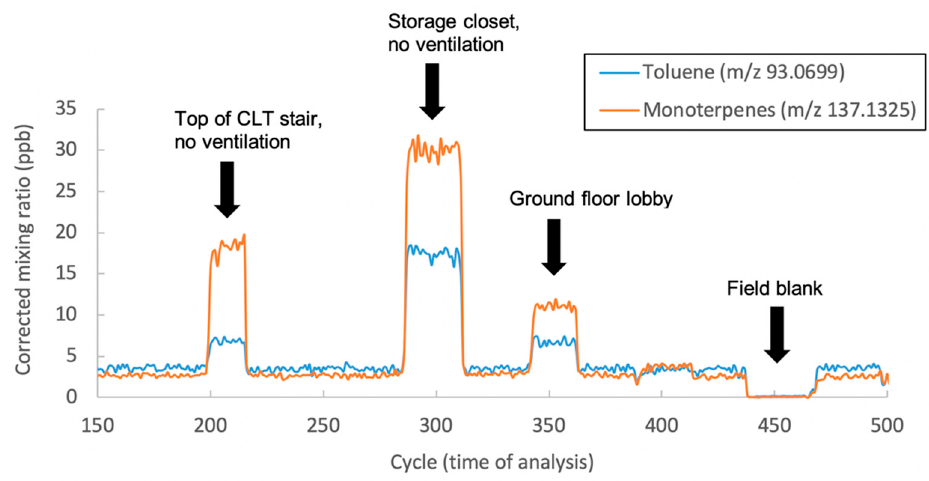
Figure 4. Results for toluene and monoterpenes over PTR-TOF-MS analysis time for one-minute grab samples from various building locations and one field blank canister.